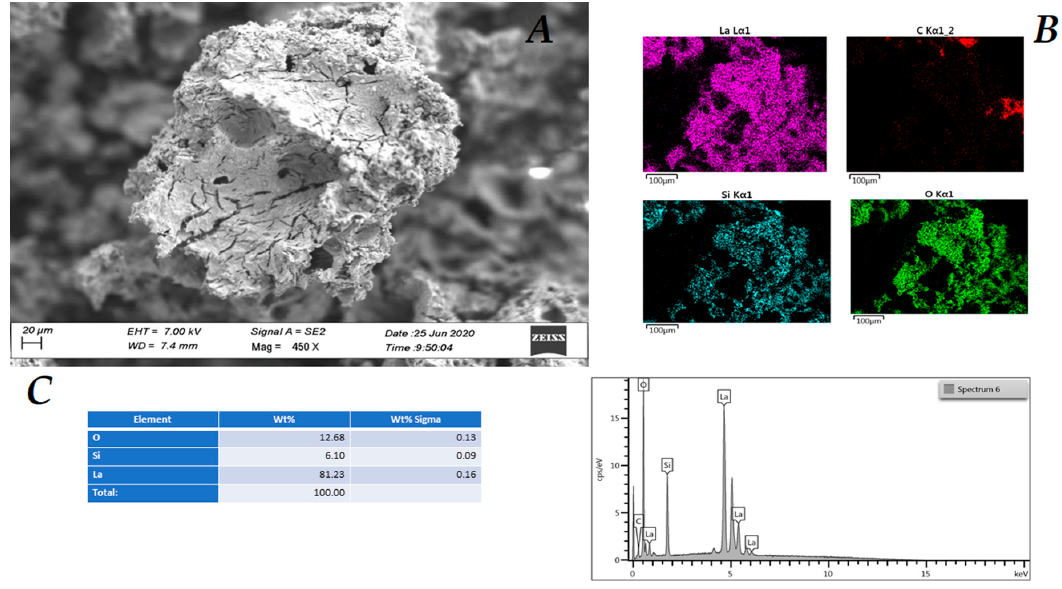
Figure 6. La(III) O-KIT-6 ( 2 ). ( A ) SEM (scanning electron microscope) image at 20 μ m; ( B ) maps of elements, ( C ) EDS (energy dispersive X-ray analysis) analysis and composition.